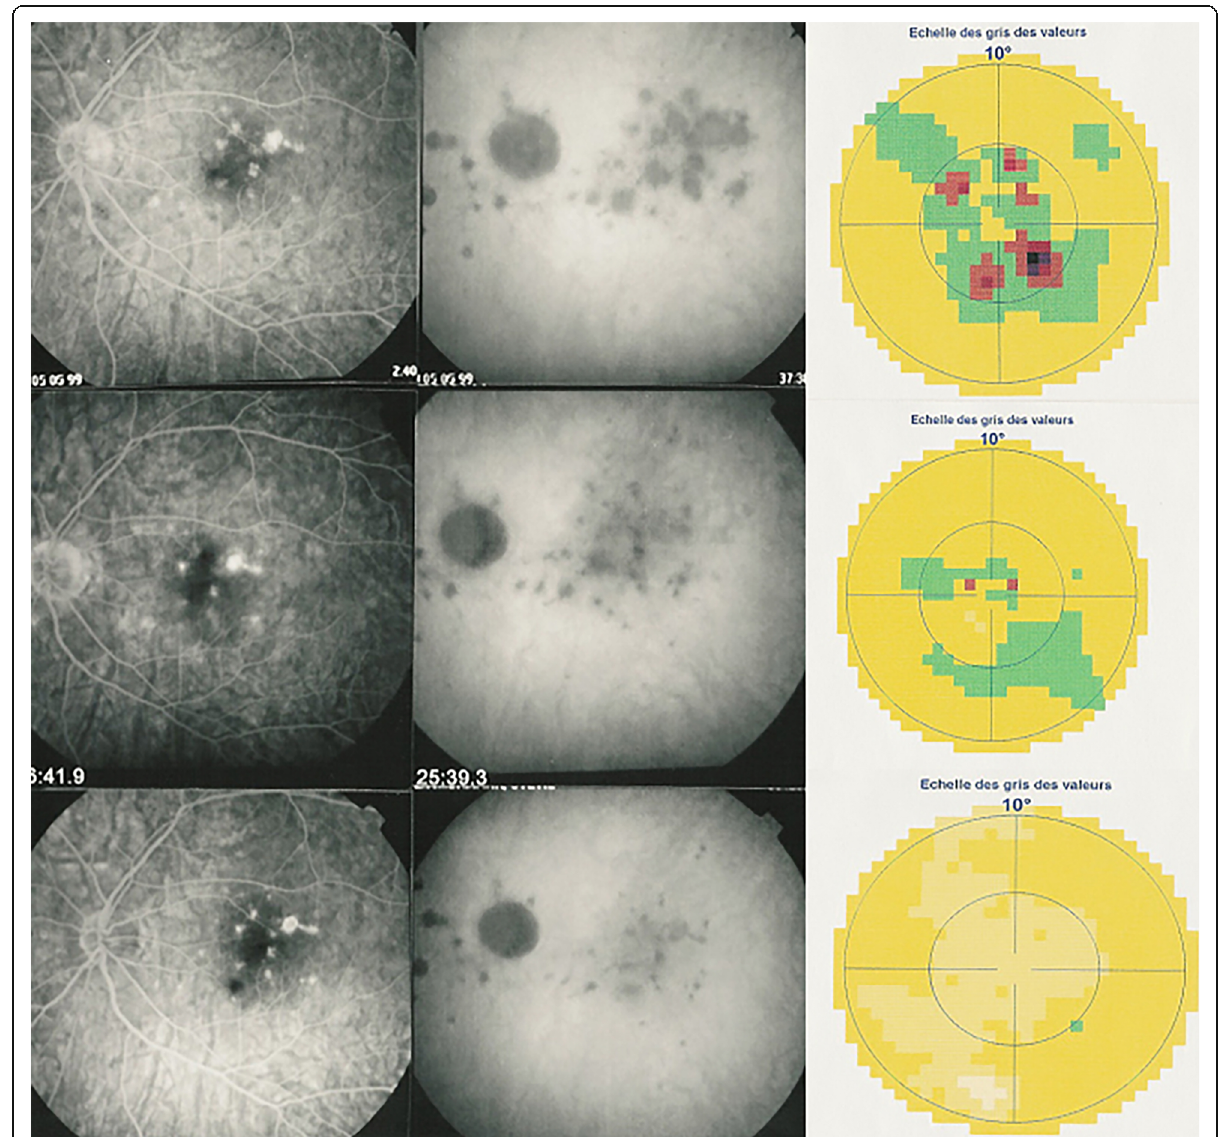
Fig. 12 Correlation between FA, ICGA and visual field during corticosteroid treatment of MFC. This myopic patient presents with left eye photopsias, left decrease of visual acuity (VA) and the presence of a subjective left scotoma. FA (top left) only shows cicatricial FA lesions corresponding to cicatricial fundus lesions seen on fundus examination. ICGA (top middle) shows widespread hypofluorescent areas indicating fresh choriocapillaris lesions with corresponding visual field defects (top right). During corticosteroid therapy, practically no change is seen on FA, whereas ICGA signs of active disease progressively resolve together with visual field improvement (right column). (Reprinted from Diagnostics (Basel). 2021 May 24;11 (6):939.